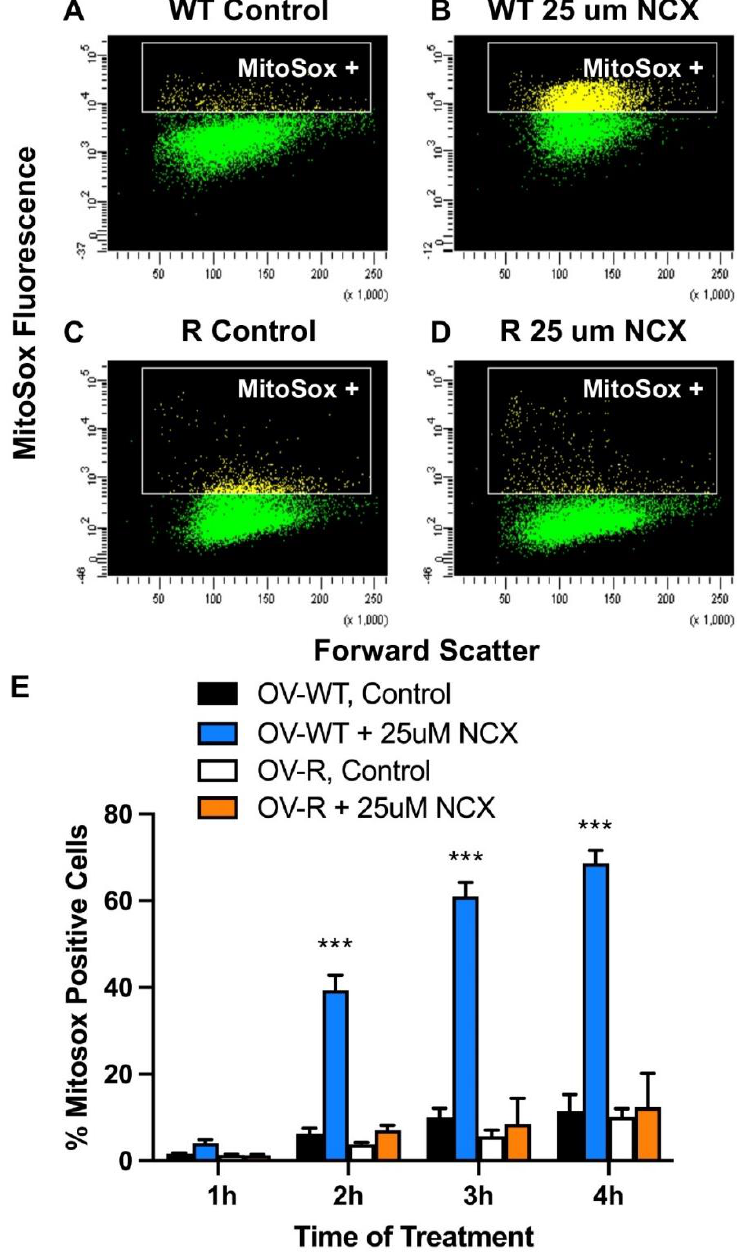
Figure 4. Formation of Mitosox positive cells in OVCAR-8 and NCI/ADR-RES cells during incubation with NCX4040 (25 µ M) with time ( E ). Plots ( A – D ) were obtained at 2 h of drug treatment and representative plots are shown here. *** p -values <0.001 compared to time-matched control and NCI/ADR-RES.